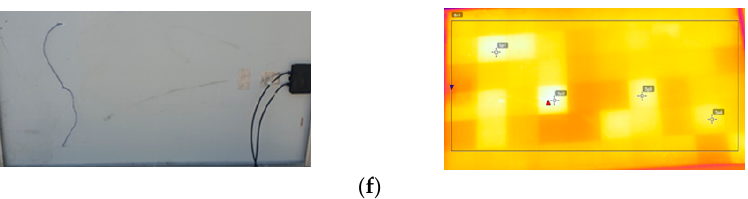
types: ( a ) hotspot, ( b ) diode failure, ( c ) connector breakage, ( d ) panel breakage, ( e ) busbar, and ( f )